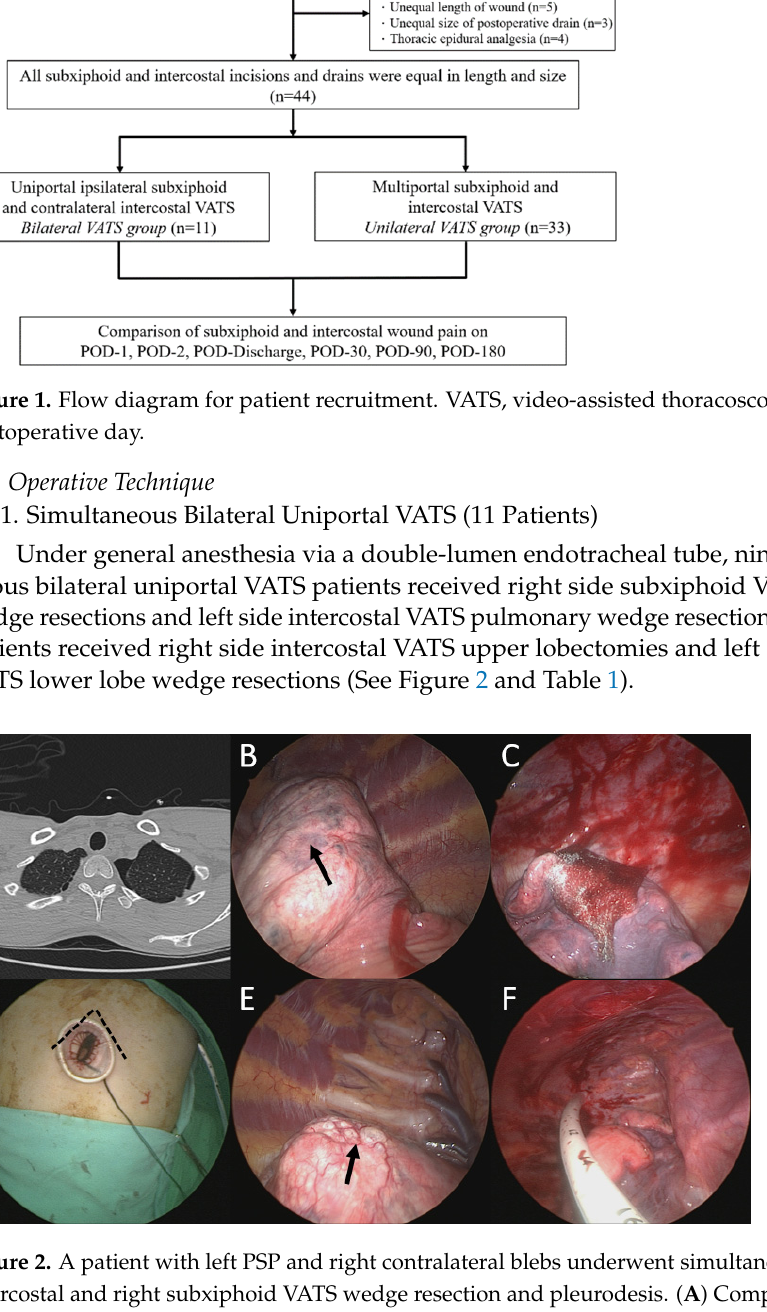
Figure 1. Flow diagram for patient recruitment. VATS, video-assisted thoracoscopic surgery; POD, postoperative day.